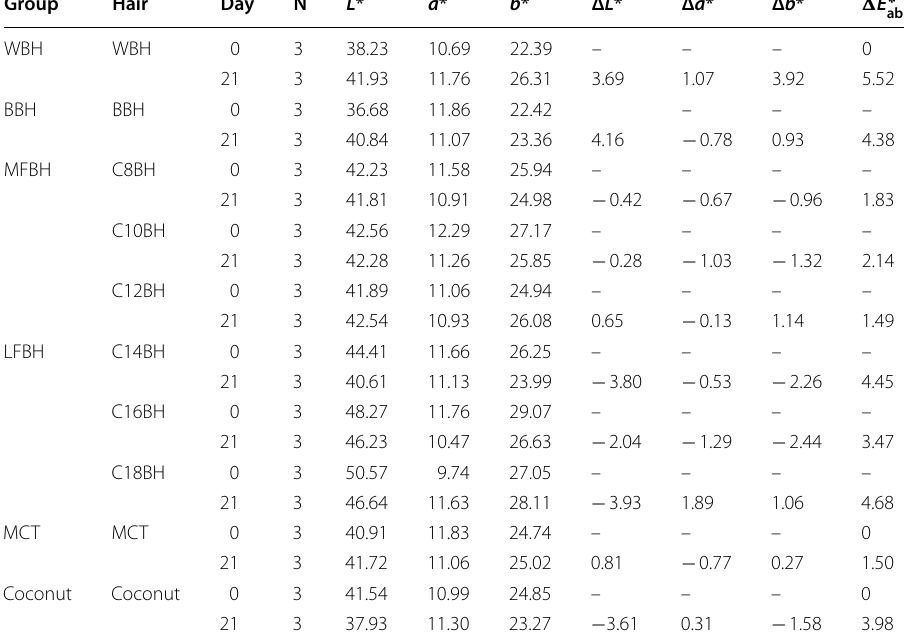
Table 5 Color values of bleached hair (BH) before and after 21 days of applying different hair treatments